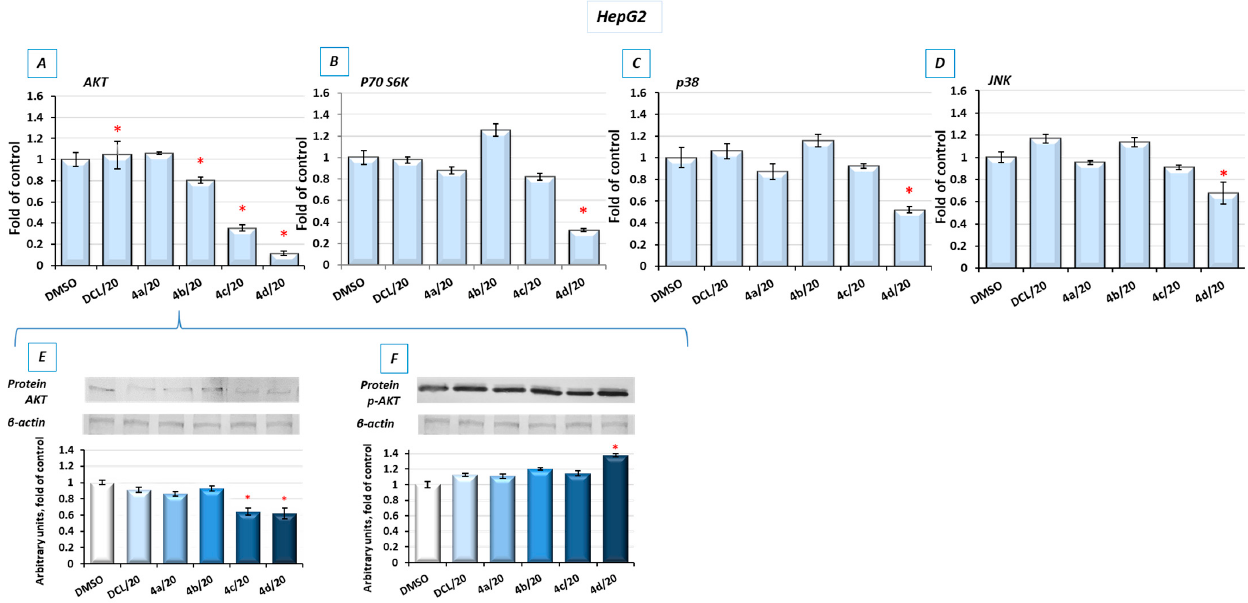
Figure 8. The effect of the DCL and DCL–OAO derivative conjugates ( 4a – 4d in 20 µ M concentration) on the cytosolic level of AKT ( A ), p70 S6 kinase ( B ), p38 ( C ), and JNK ( D ) measured in the cytosolic fractions of the HepG2 cells (after 24 h incubation) and calculated on the MAGPIX ® System. ( E , F ) The protein levels of AKT and p ‐ AKT (phosphorylation site Ser 473), respectively assessed by a Western blot, where β‐ actin was used as a loading control. The results expressing the mean fluorescence intensity (MFI) are presented as the fold of control from three independent measurements. The values (mean ± SEM) were calculated as protein levels in comparison to control cells set to 100%. * Significantly different from control, DMSO ‐ treated cells, p < 0.05. Statistical significance was assessed by Student’s ‐ t ‐ test.